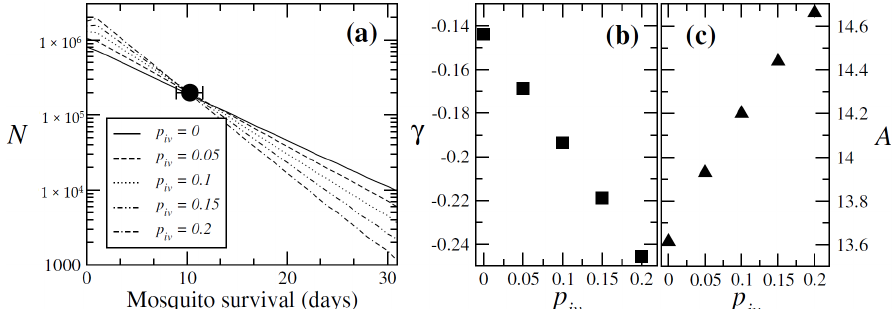
Figure 5. ( a ) Mosquito survival distribution curve for 30 year time series (five samples), uncovering an intersecting point around 10 days. The exponential fit N = A exp ( γ t ) has parameters, γ and A , which vary linearly with P iv as shown in ( b , c ). In all cases, high heterogeneity ( θ = 0.25) and low human-to-mosquito transmission efficiency ( w h = 0.5) are fixed.